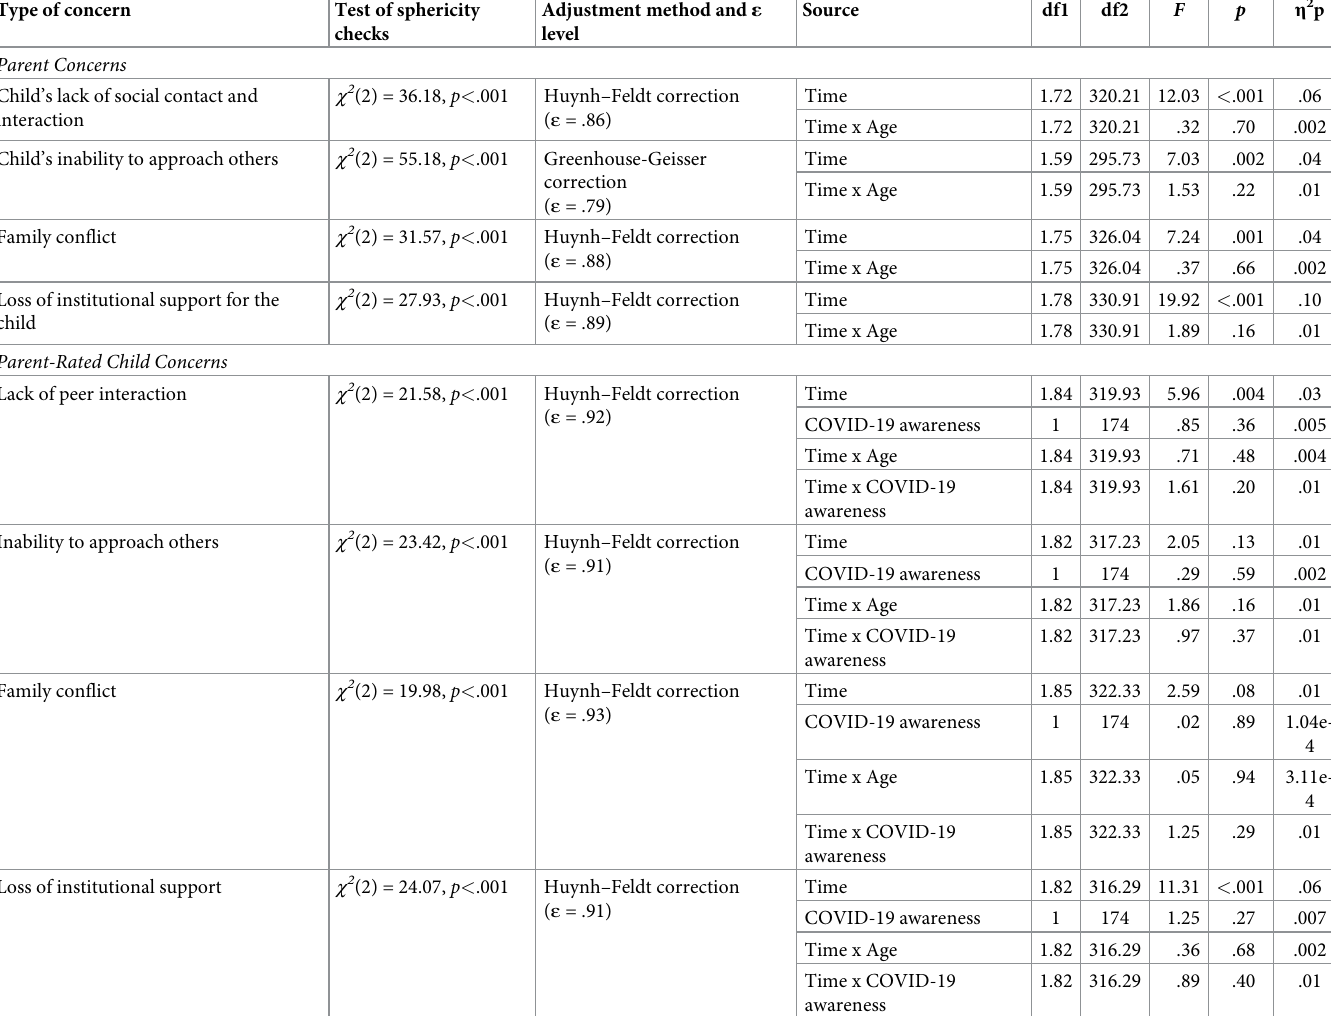
Table 3. Sphericity violations and ANCOVA for ratings of social concerns.